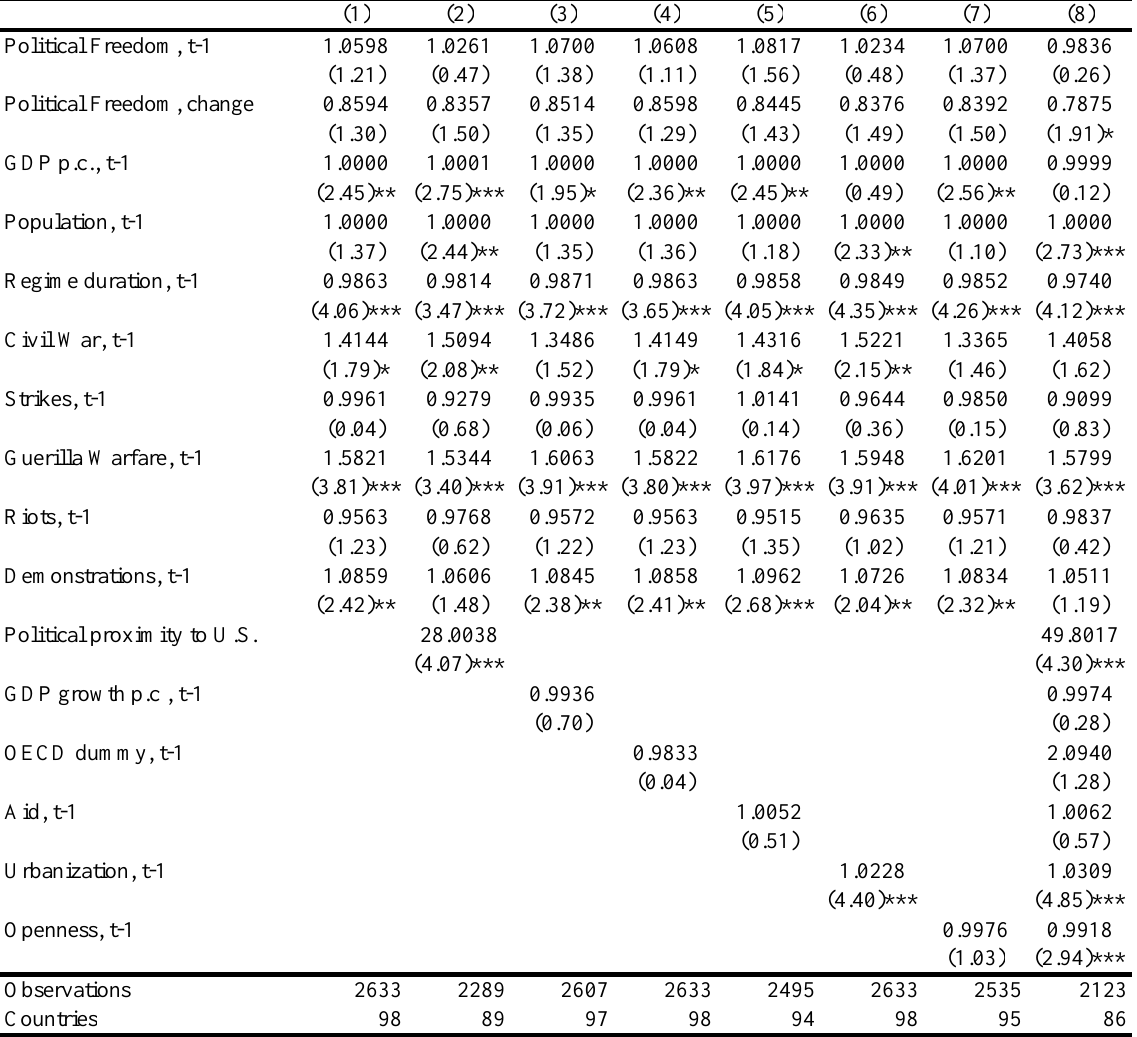
Table 6: Determinants of International Terror Events (Median Severity International Terror Event), Developing and Developed Countries, 1972-2003, Fixed-Effects Negative Binomial Panel